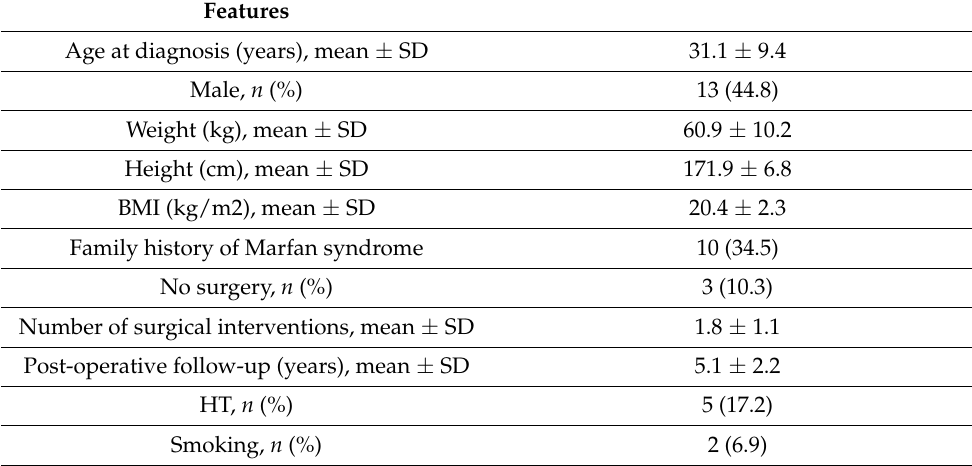
Table 1. Patient demographics, clinical features, and outcomes of patients with Marfan syndrome. Features